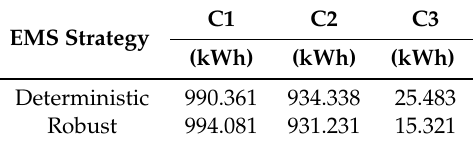
Table 4. Energy distribution at different prices.